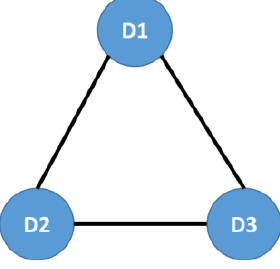
Figure 1. Structure of the Morbidity Network.